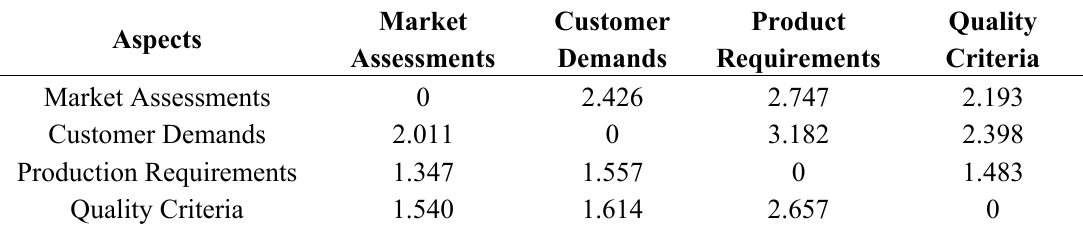
Table 2. Direct-Relation Matrix ( D ) for Aspects.